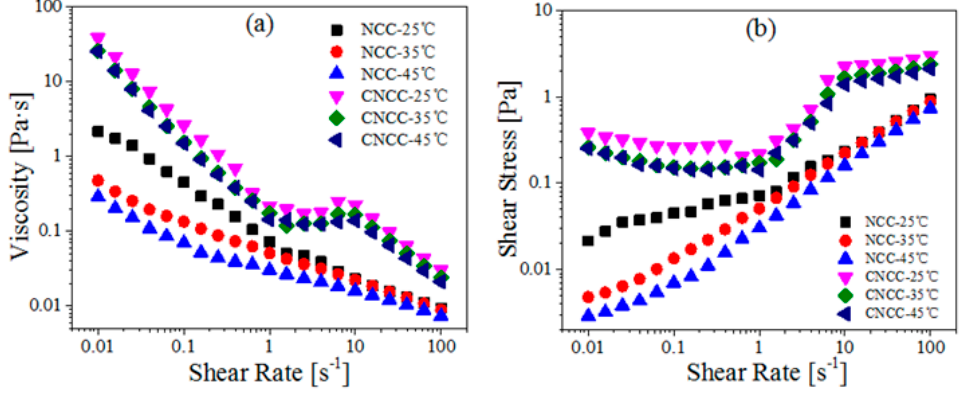
Figure 5. ( a ) Viscosity and ( b ) Shear stress as a function of shear rate for NCC and CNCC suspensions at different temperatures (25, 35, 45 °C).